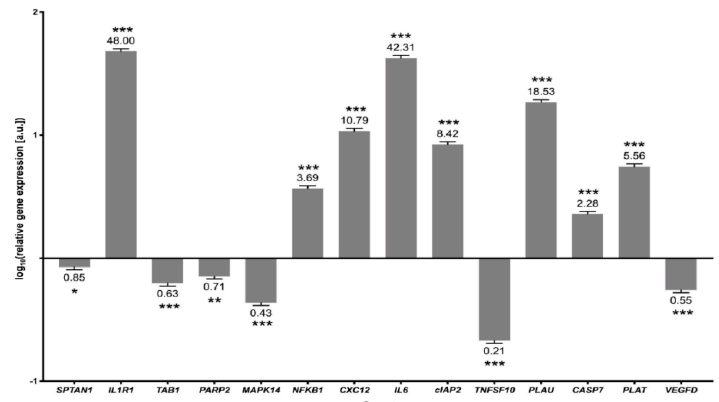
Figure 6. The mRNA expression of selected genes obtained from Real-Time PCR. The values (above and beneath the bars) indicate the changes relative to the normalized expression value of the reference gene ACTB. Arbitrary unit value is set as 1 [a.u.]. Genes with expression value <1 were downregulated and >1 were upregulated. All the relative expression values were presented in logarithmic scale (log10). p -values are considered statistically significant at <0.05 (*), <0.01 (**) and <0.0002